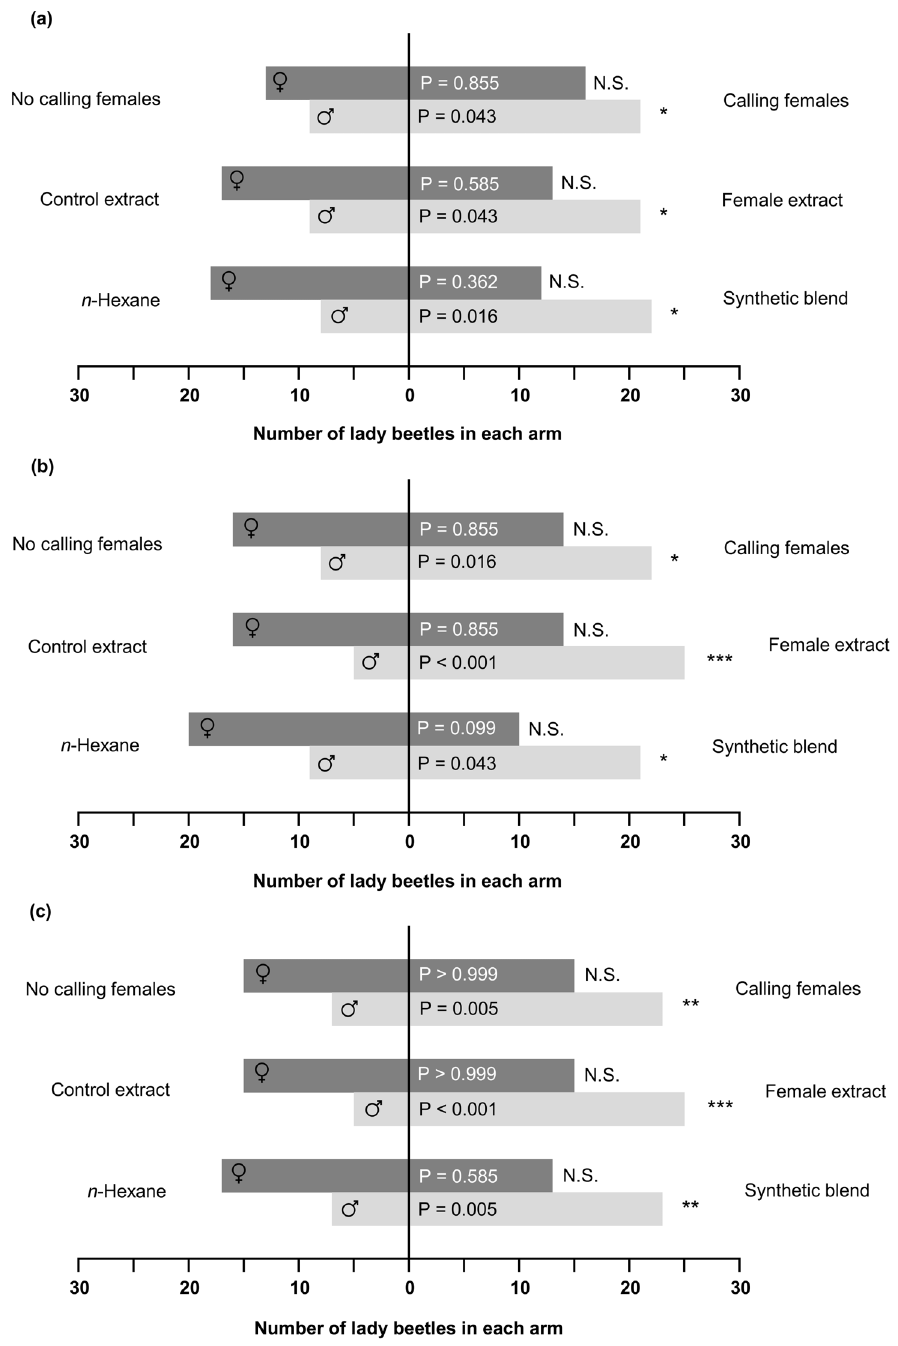
Fig. 3. Behavioral responses of H. axyridis toward the tested odor sources. The choice between the two arms was observed for individual male and female ladybeetles (n 5 30 for both genders in each of the three sets of experiments), in relation with (a) the first entered zone, (b) the zone where the lady beetle stayed for the longest period of time, and (c) the last entered zone. Statistical differences are indicated by asterisks at P , 0.05 (*), P , 0.01 (**), and P , 0.001 (***) respectively, whereas N.S. indicates no significant difference (two- sided binomial